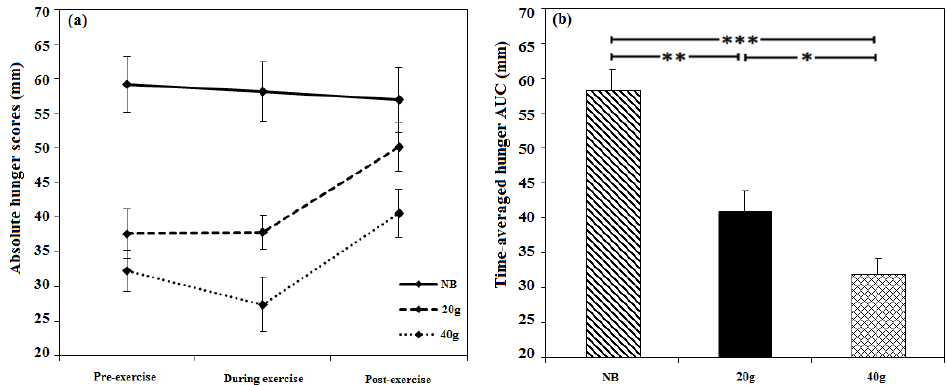
Figure 5. The effects of consuming breakfast cereal (20 g or 40 g) or no breakfast (NB) prior to exercise on pre-, during and post-exercise hunger in habitually active females ( n = 24). Values are ( a ) absolute and ( b ) time-averaged AUC (* p < 0.05, ** p < 0.01, *** p <0.001).